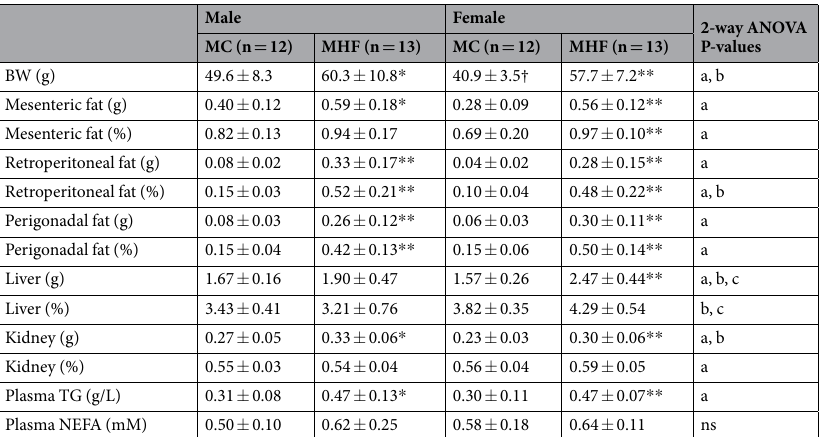
Table 2. Body weight and organ mass of male and female offspring at weaning. Results are expressed as means ± SD. The data were analysed using two-way ANOVA with Bonferroni post hoc test. MC (offspring of dams fed chow); MHF (offspring of dams fed high-fat diet). * P < 0.05, ** P < 0.01 (vs MC offspring); † P < 0.05 (vs male offspring), a (P < 0.05, Maternal diet effect), b (P < 0.5, Sex effect), c (P < 0.05, interaction effect). BW (Body weight), BGL (Blood glucose